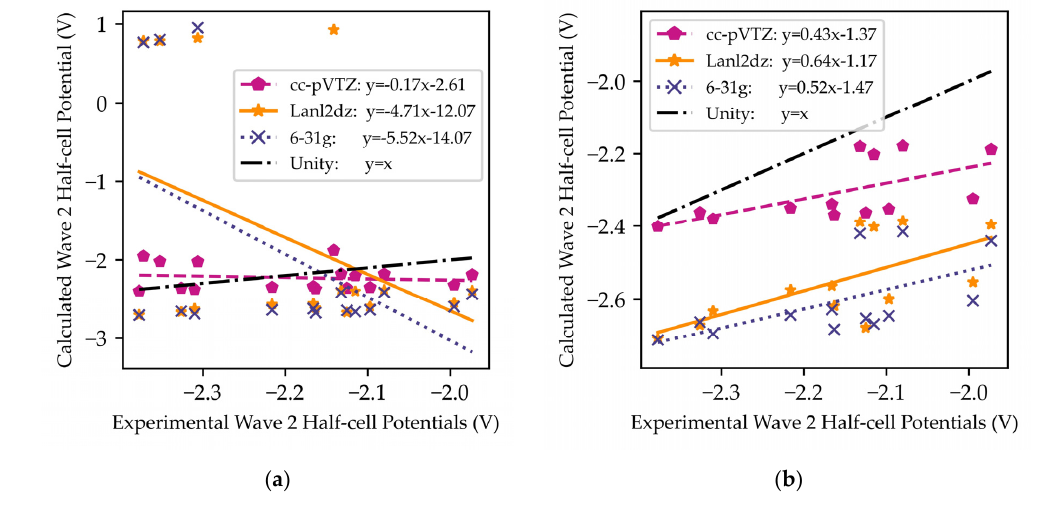
Figure A2. Comparison of computational electrochemical cell potentials vs. experimental electro- chemical cell potentials for ( a ) wave 2 and ( b ) wave 2 without the nitro groups. The B3LYP/cc-pVTZ method is indicated by pink pentagons and the previously calculated methods B3LYP/lanl2dz and B3LYP/6-31G [27] are indicated with blue crosses and yellow stars, respectively. Derivative C3, B1 and D1are excluded from analysis.